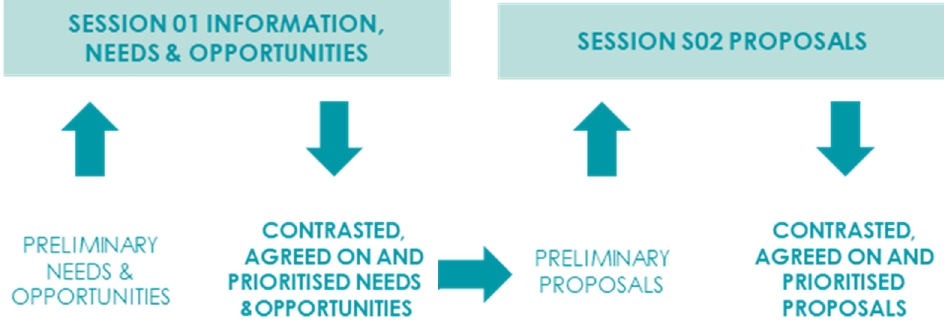
Figure 4. Face-to-face participation diagram (developed by the authors). Figure 4. Face ‐ to ‐ face participation diagram (developed by the authors). Figure 4. Face ‐ to ‐ face participation diagram (developed by the authors).